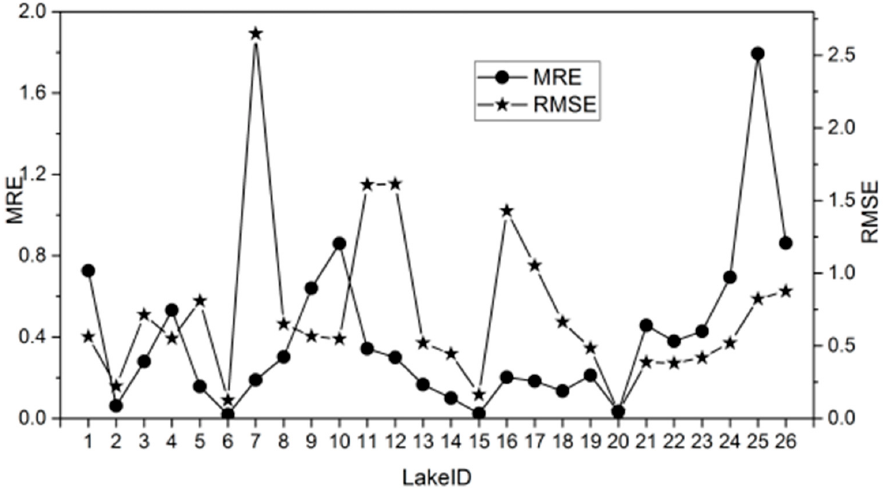
Figure 5. The mean relative error (MRE) and root-mean-square error (RMSE) of the K d (PAR) regression models for each lake for the evaluation of the spatial transferability of the model. LakeID was corresponding to Table 1 and was represented on the x-axis.